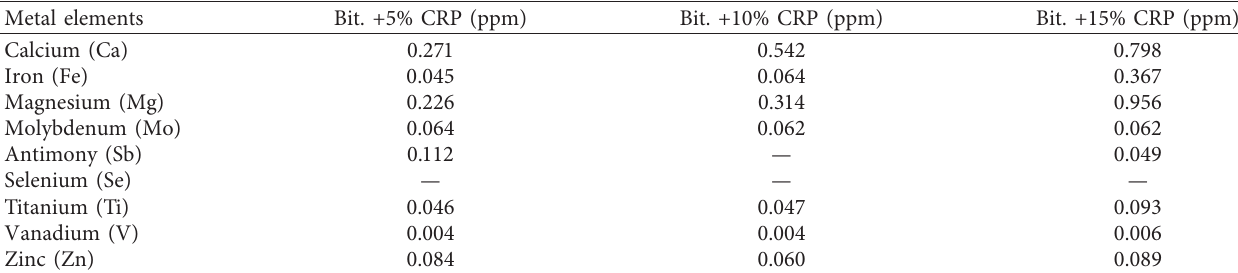
Table 8: Metal elements’ concentrations on CRP-modified bitumen leachate solution.